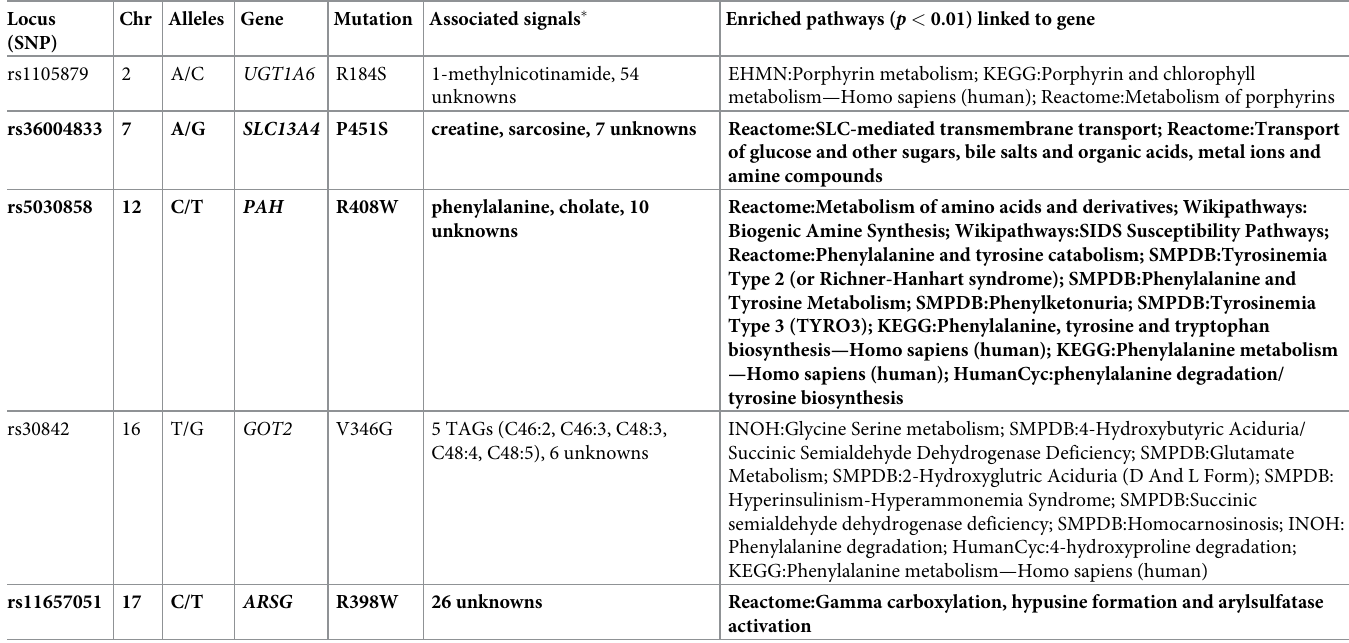
Table 2. Top loci identified during genetic validation of BioAge pathway annotations.